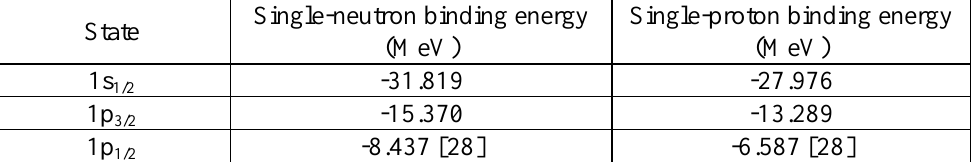
Table 4: Single-nucleon binding energies for 10 B.